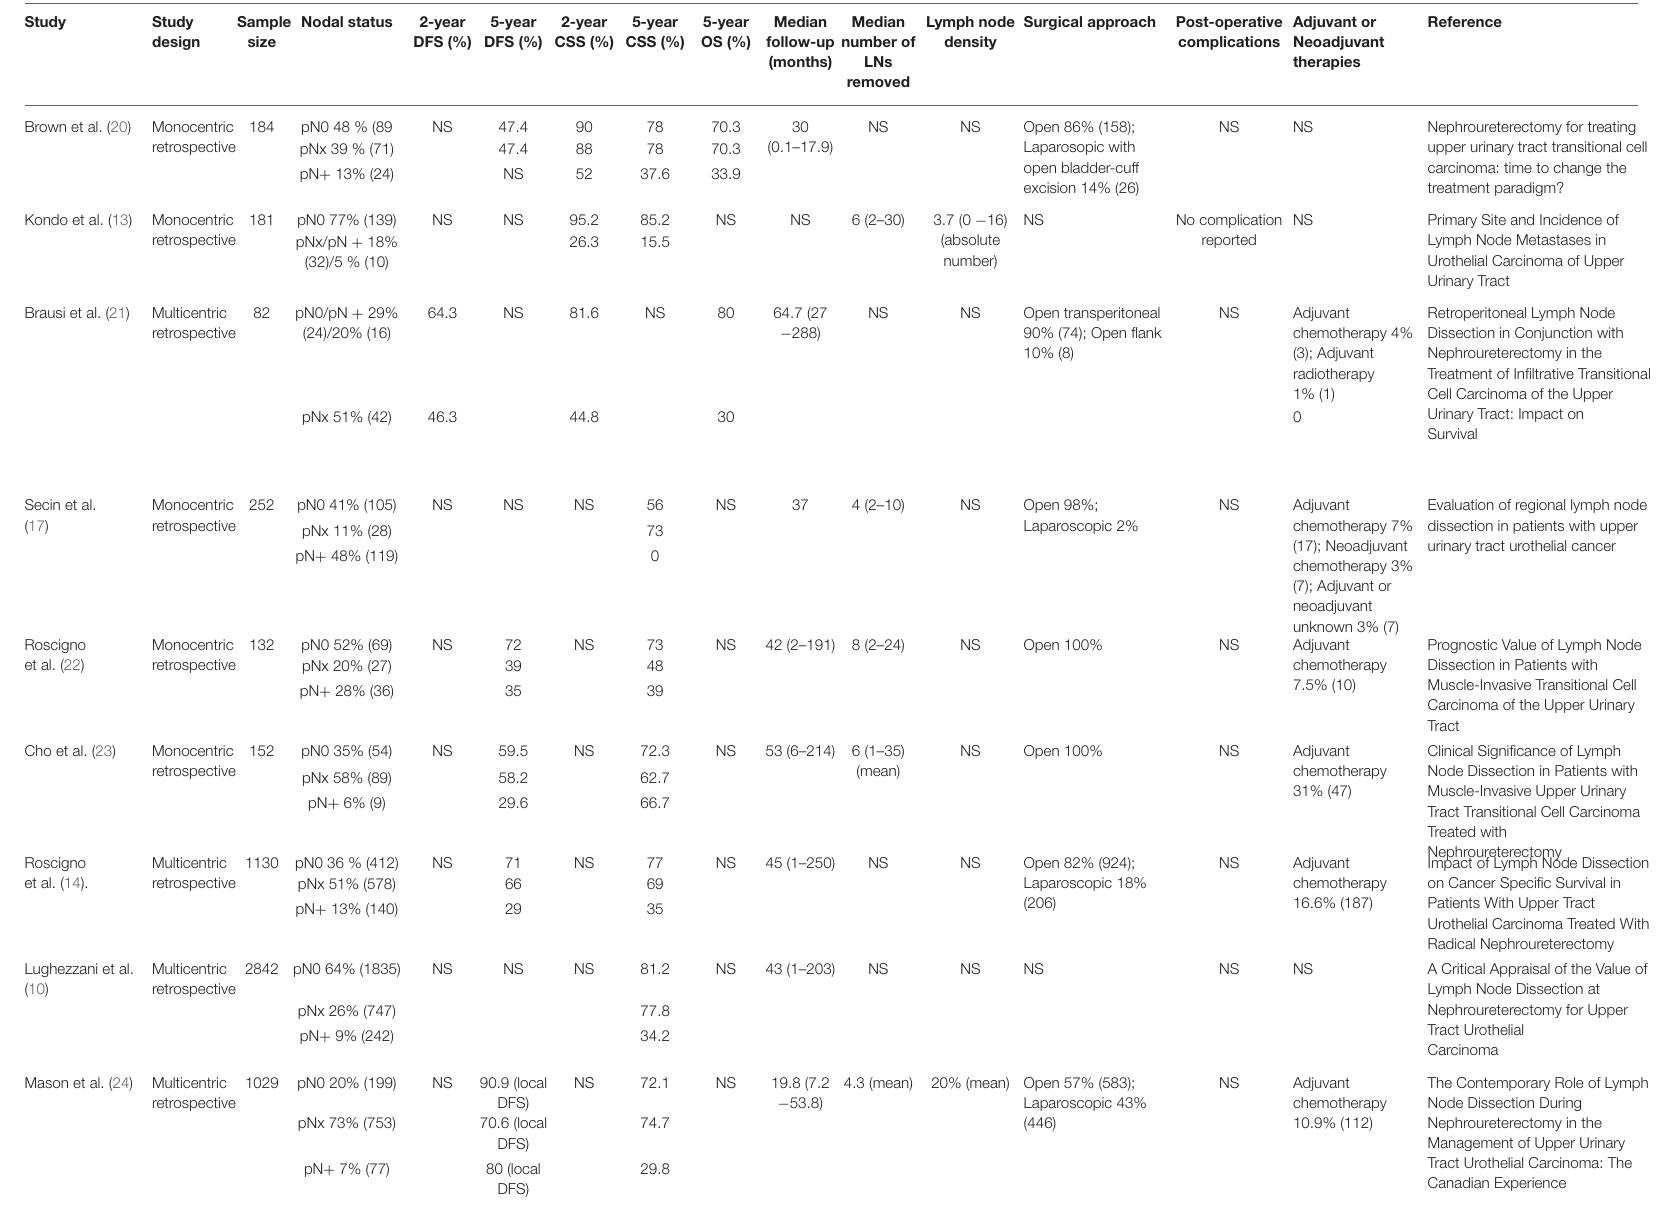
TABLE 1 | Staging role of LND.